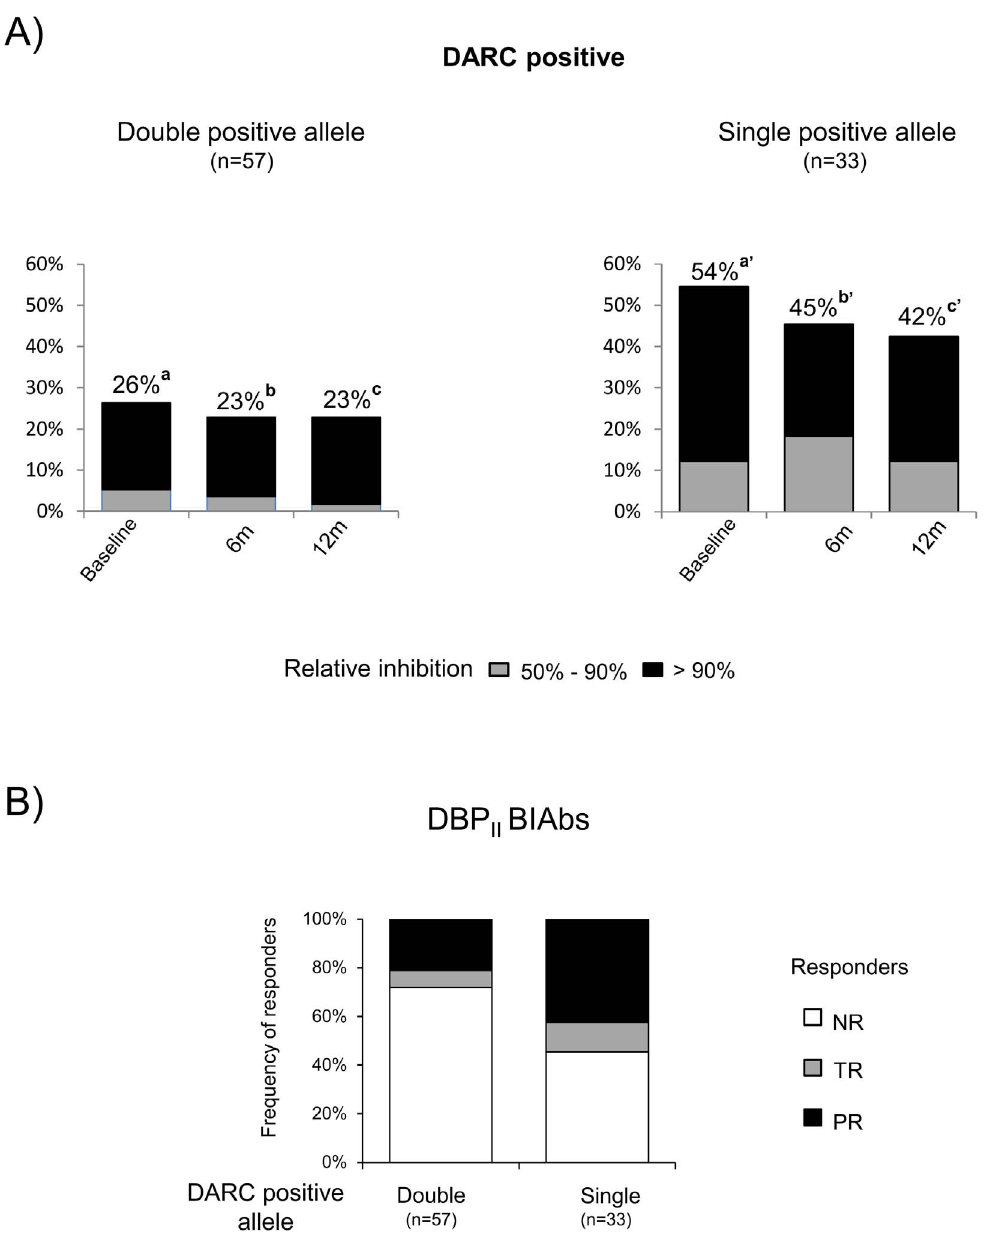
Figure 3. DARC polymorphisms affect the functional properties of DBPII antibodies. DBPII binding inhibitory antibodies (BIAbs) were evaluated in plasma from individuals stratified according to DARC alleles, as carrying double positive alleles ( FY*A/FY*A , FY*A/FY*B , FY*B/FY*B ) or a single positive allele ( FY*A/FY*B ES , FY*B/FY*B ES ). A) Frequencies of BIAbs (top of the columns) at three consecutive surveys showed DBPII BIAbs to be significantly more frequent in single positive allele carriers than in double positive carriers (significant differences between a vs. a 9 ; b vs. b 9 and c vs. c 9 , as determined by by Z-test, P , 0.05.); B) After 12-months, the BIAbs response was more persistent in the group carrying a single DARC -positive allele (Z-test=3.002; P=0.0027). NR = non-responder, no inhibitory antibody response detected at any time-point of the study; TR = temporary responder, inhibitory antibodies in at least one cross-sectional survey; (PR = persistent responder; inhibitory antibodies detected in all surveys. BIAbs were evaluated by COS-7 cyto-adherence assay, with plasma samples at 1:40 and positive results as DBPII –DARC binding inhibition $